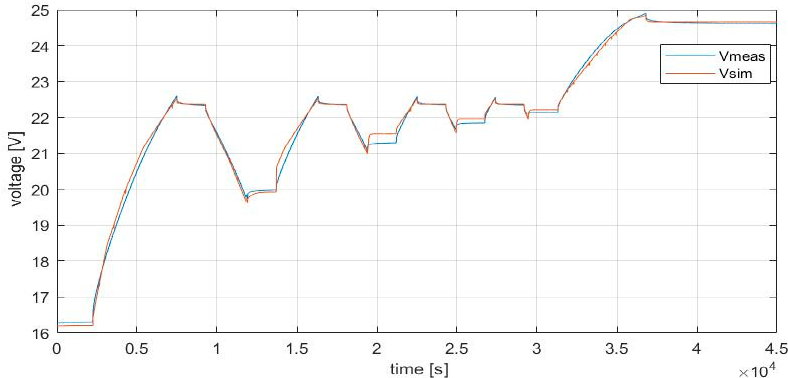
Figure 16. Results without hysteresis modeling.